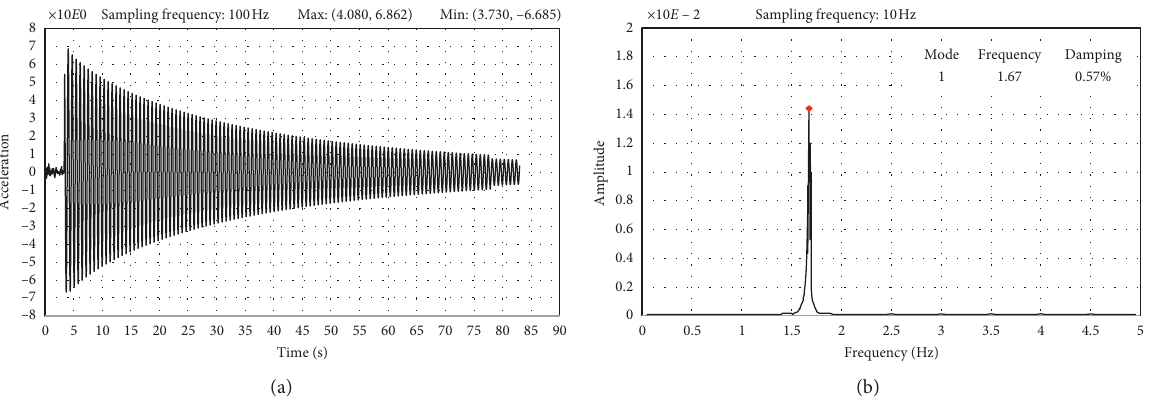
Figure 19: Monitoring results with the particle damper (14 glass balls in container). (a) Acceleration-time history curve of the frame. (b) Identified frequency and damping